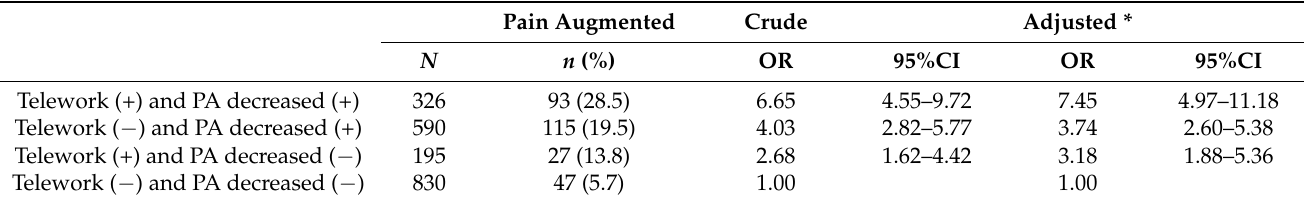
Table 3. Association between ‘the combination of telework and physical activity’ and pain